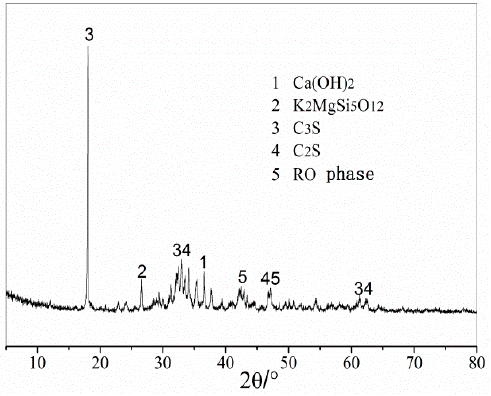
Figure 3. XRD test results of steel slag aggregate.